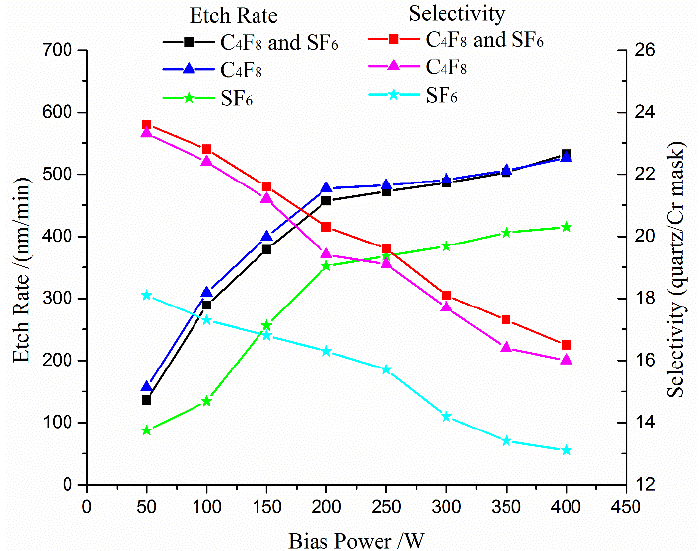
Figure 3. The test results of the etching rate and selectivity influenced by bias power.